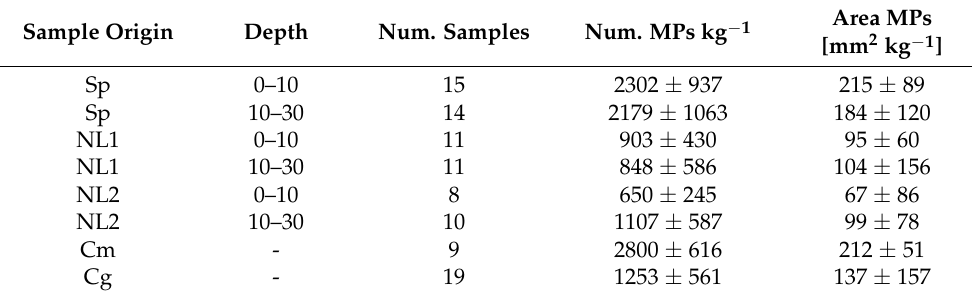
Table 2. Number of analysed samples and average microplastic contents for all origins